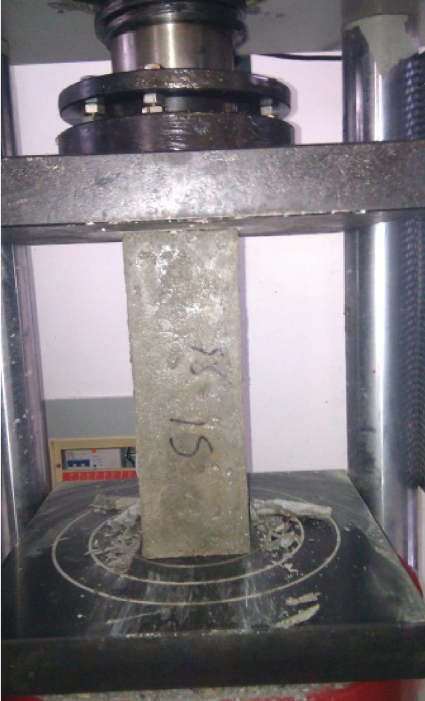
Figure 9: Strength of concrete prism.